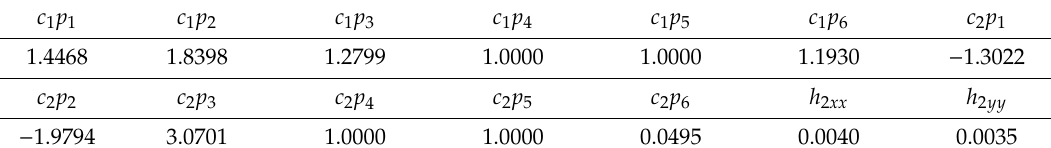
Table 9. Parameters of the extended Drucker potential function for AA 2008-T4 sheet.